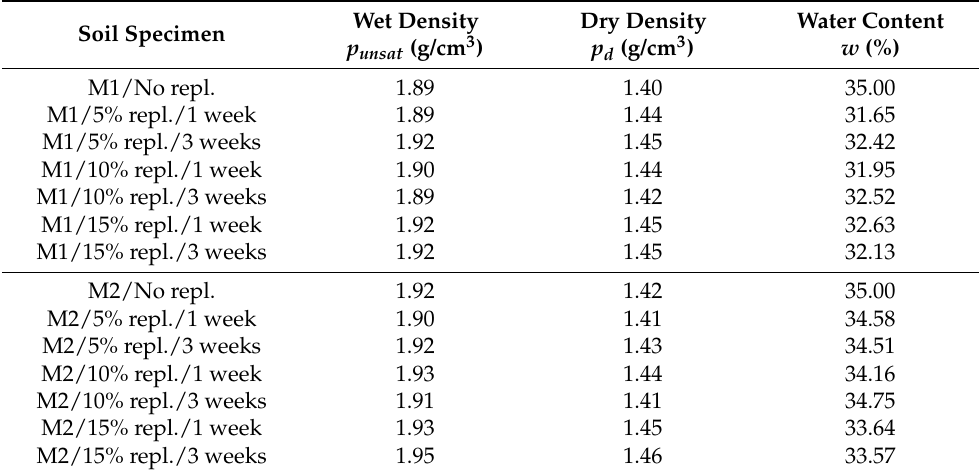
Table 2. Summary of measured wet densities ( p unsat ), dry densities ( p d ) and water contents ( w ) of soil specimens from the M1 and M2 series used for oedometer